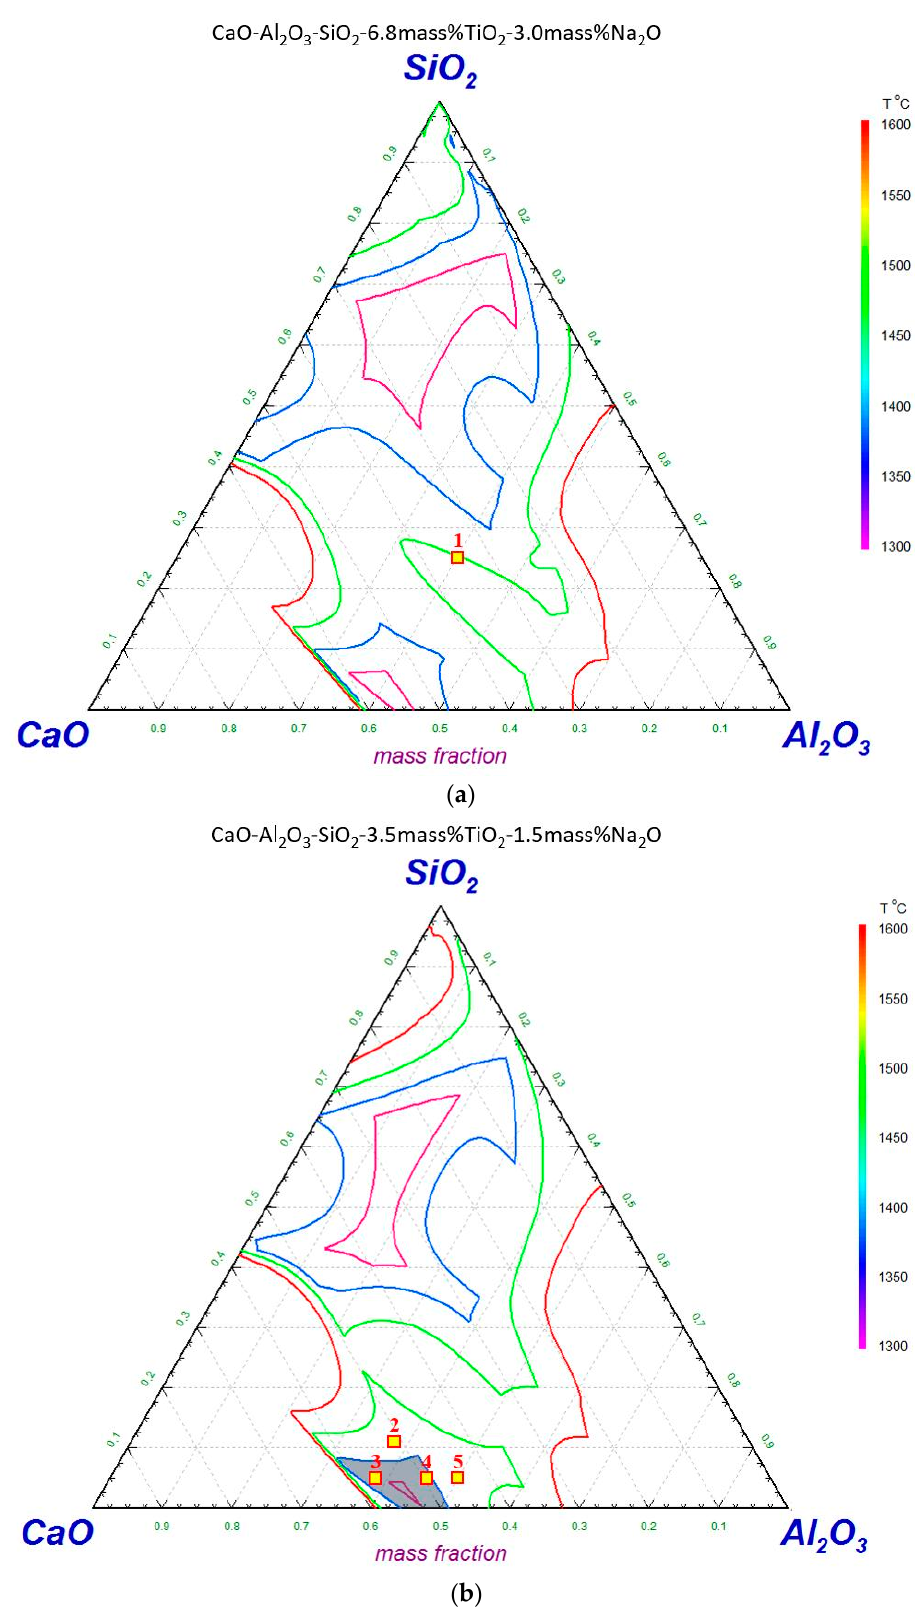
Figure 10. Isothermal liquidus curves of the CaO-Al 2 O 3 -SiO 2 -6.8 mass% TiO 2 -3.0 mass% Na 2 O slag system ( a ) and CaO-Al 2 O 3 -SiO 2 -3.5 mass% TiO 2 -1.5 mass% Na 2 O slag system ( b ).